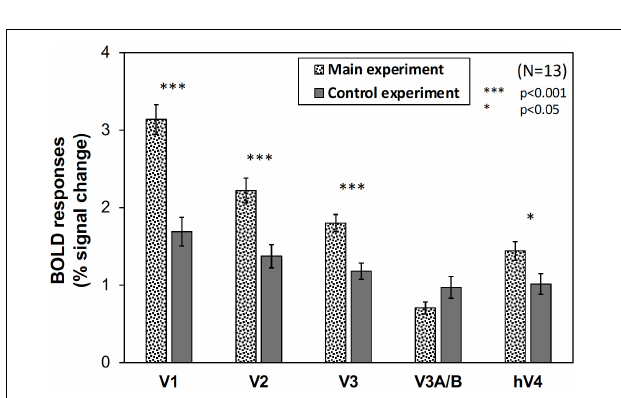
FIGURE 6 | The magnitude (% signal change) of BOLD responses in main and control experiments. The values were averaged across all Chroma conditions and subjects. Error bars denote SEM among the subjects. Significant differences in V1 ( p < 0.001), V2 ( p < 0.001), V3 ( p < 0.001), and hV4 ( p < 0.05) were confirmed by t